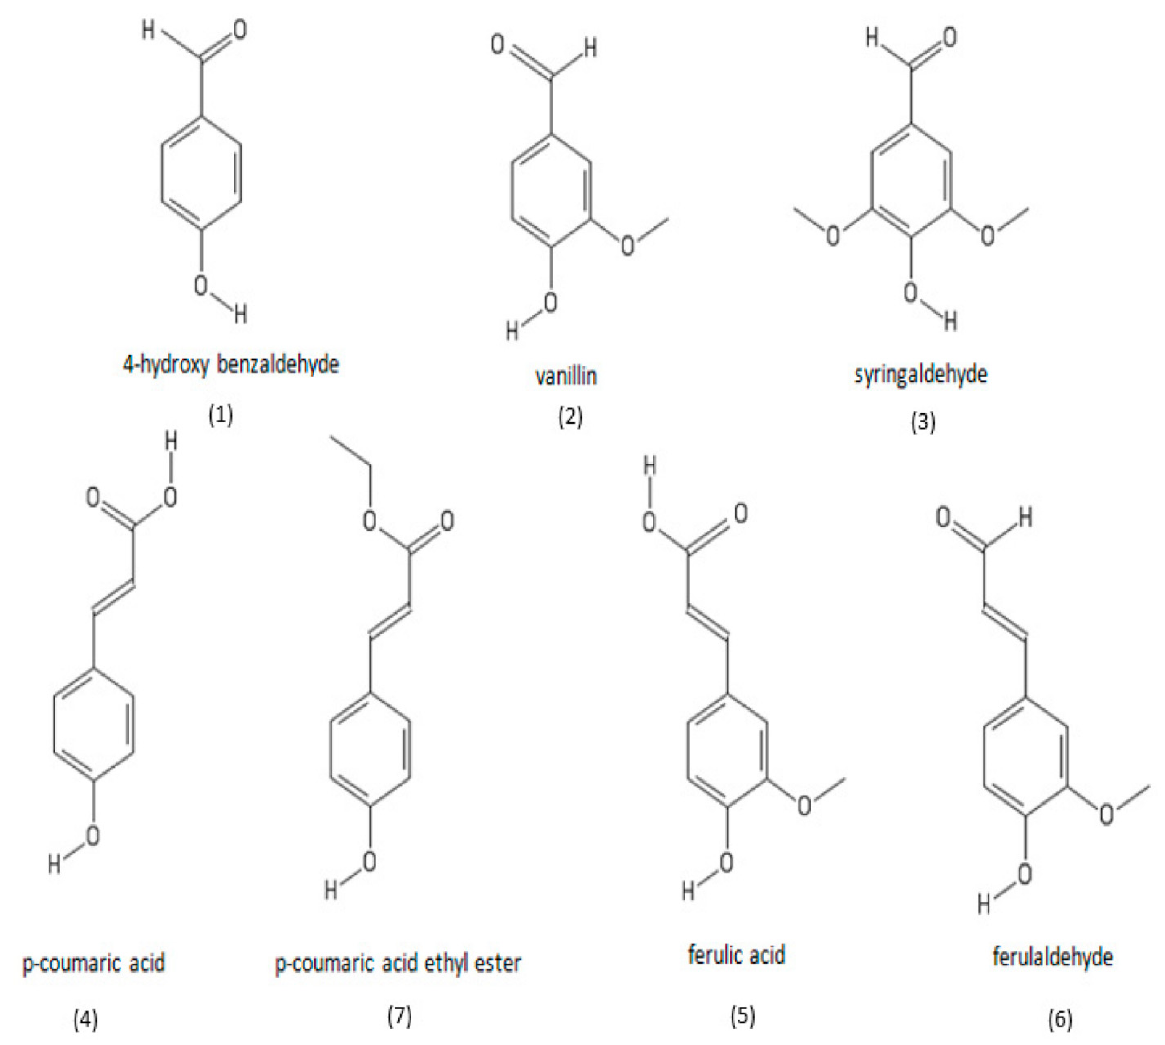
Figure 3. Structural formulas of phenolic compounds identified in prickly pear seed oil. Image from [44].